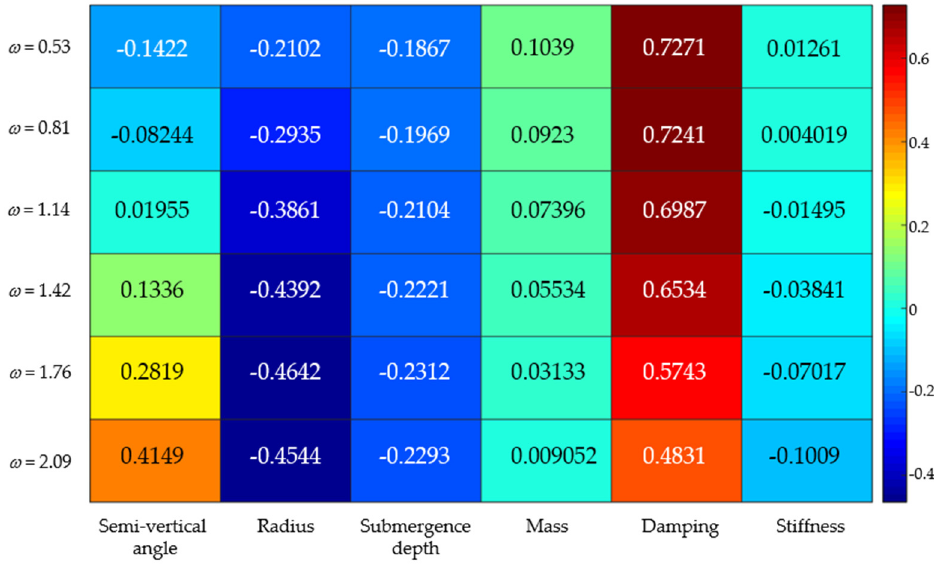
Figure 3. The correlation coefficients between the inputs and output.